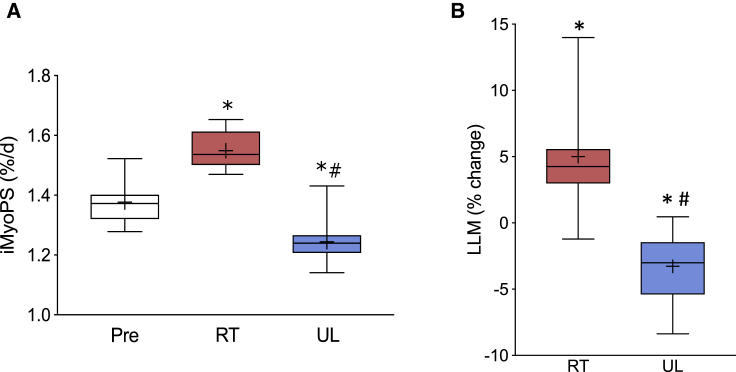
Dynamic Muscle Loading Alters Muscle Protein Synthesis (MPS) and Muscle Size(A) Absolute change in integrated myofibrillar protein synthesis rates (n = 12).(B) Percentage change in leg lean mass (LLM) after 10 weeks of unilateral RT and 2 weeks of UL, respectively (n = 12). ∗Statistically different from Pre (baseline value); #statistically different from RT value (p < 0.05).In both panels, the boxes include the 25th, 50th, and 75th quartiles and whiskers represent the maximum and minimum values. The mean value is depicted by +.See also Figure S1.